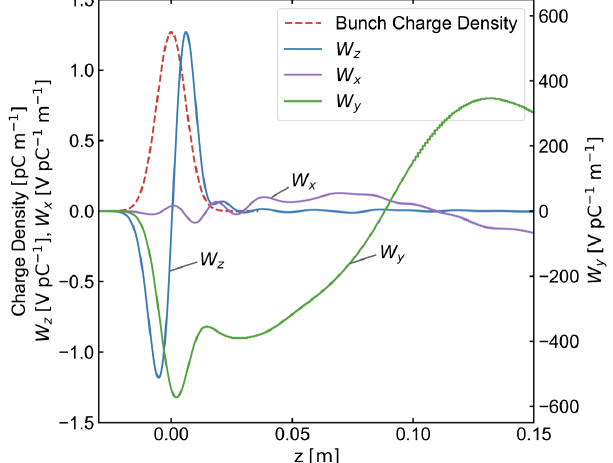
FIG. 7. Example of bunch profile, longitudinal ( W z ) and transverse ( W x , W y ) wake potentials in SuperKEKB LER (f 90 × 220 ) type vertical collimator, calculated with GDFIDL (half aperture: 2 mm). The bunch length and the beam offset from the center to the vertical or horizontal direction are 6 and 0.5 mm, respectively.